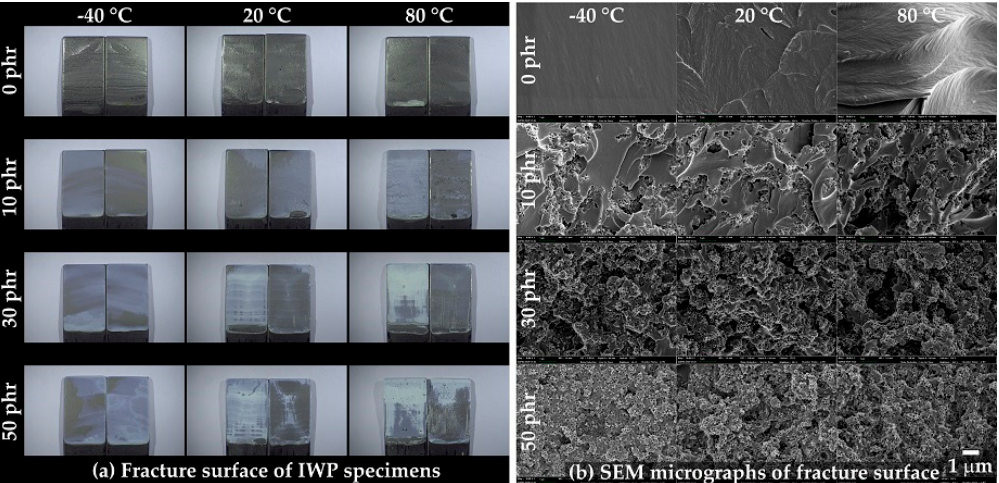
Figure 14. ( a ) Fracture surfaces of the IWP specimens captured by OM and ( b ) SEM micrographs of the fracture surfaces.